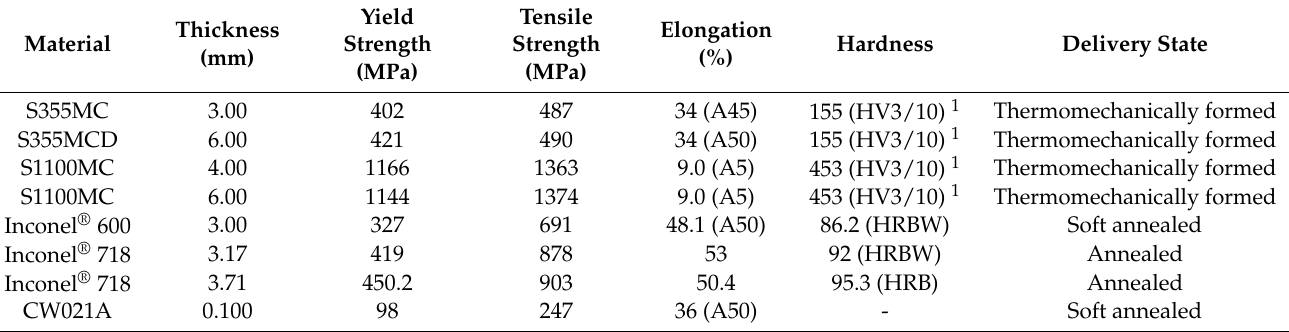
Table 1. Mechanical properties of the parent materials based on material certificates.